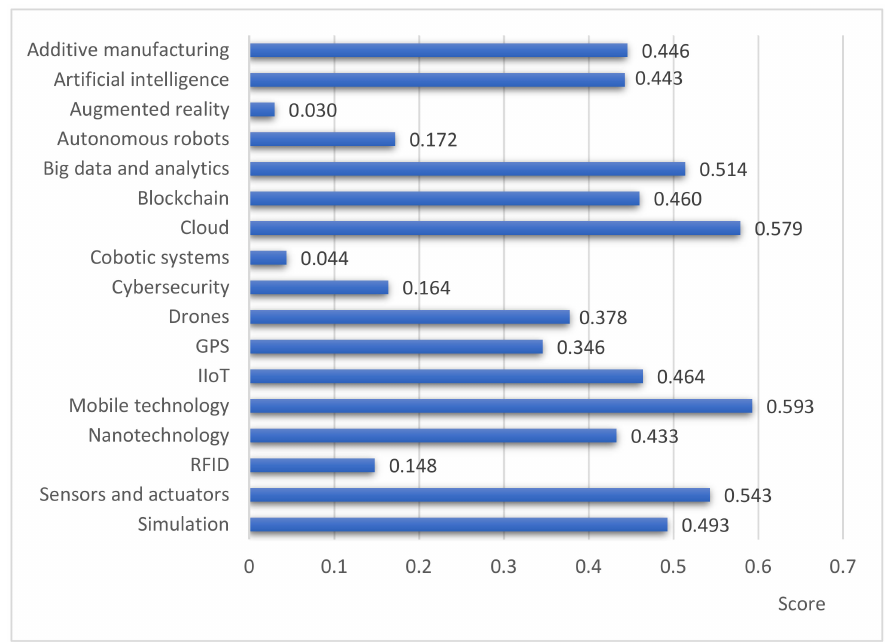
Figure 3. Study results comparing Industry 4.0